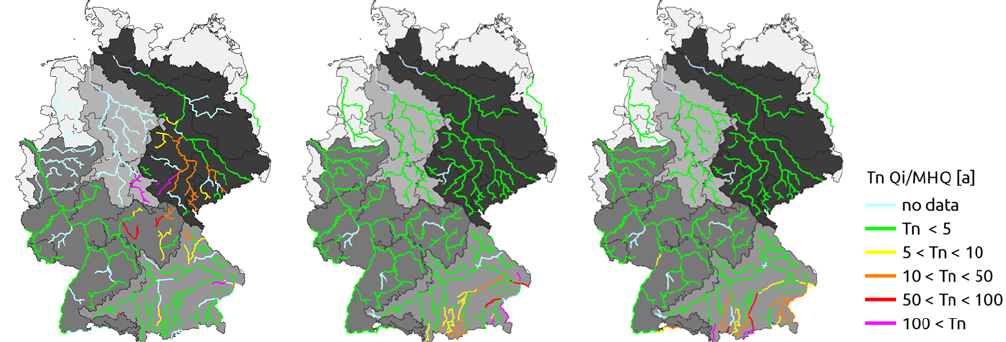
Figure 10. Return periods of initial flow ratio at meteorological event start ( Q i normalized for MHQ) derived from Q i / MHQ ratios of large-scale floods in the period from 1969 to 2009: June 2013 (left), August 2002 (middle) and July 1954 (right).